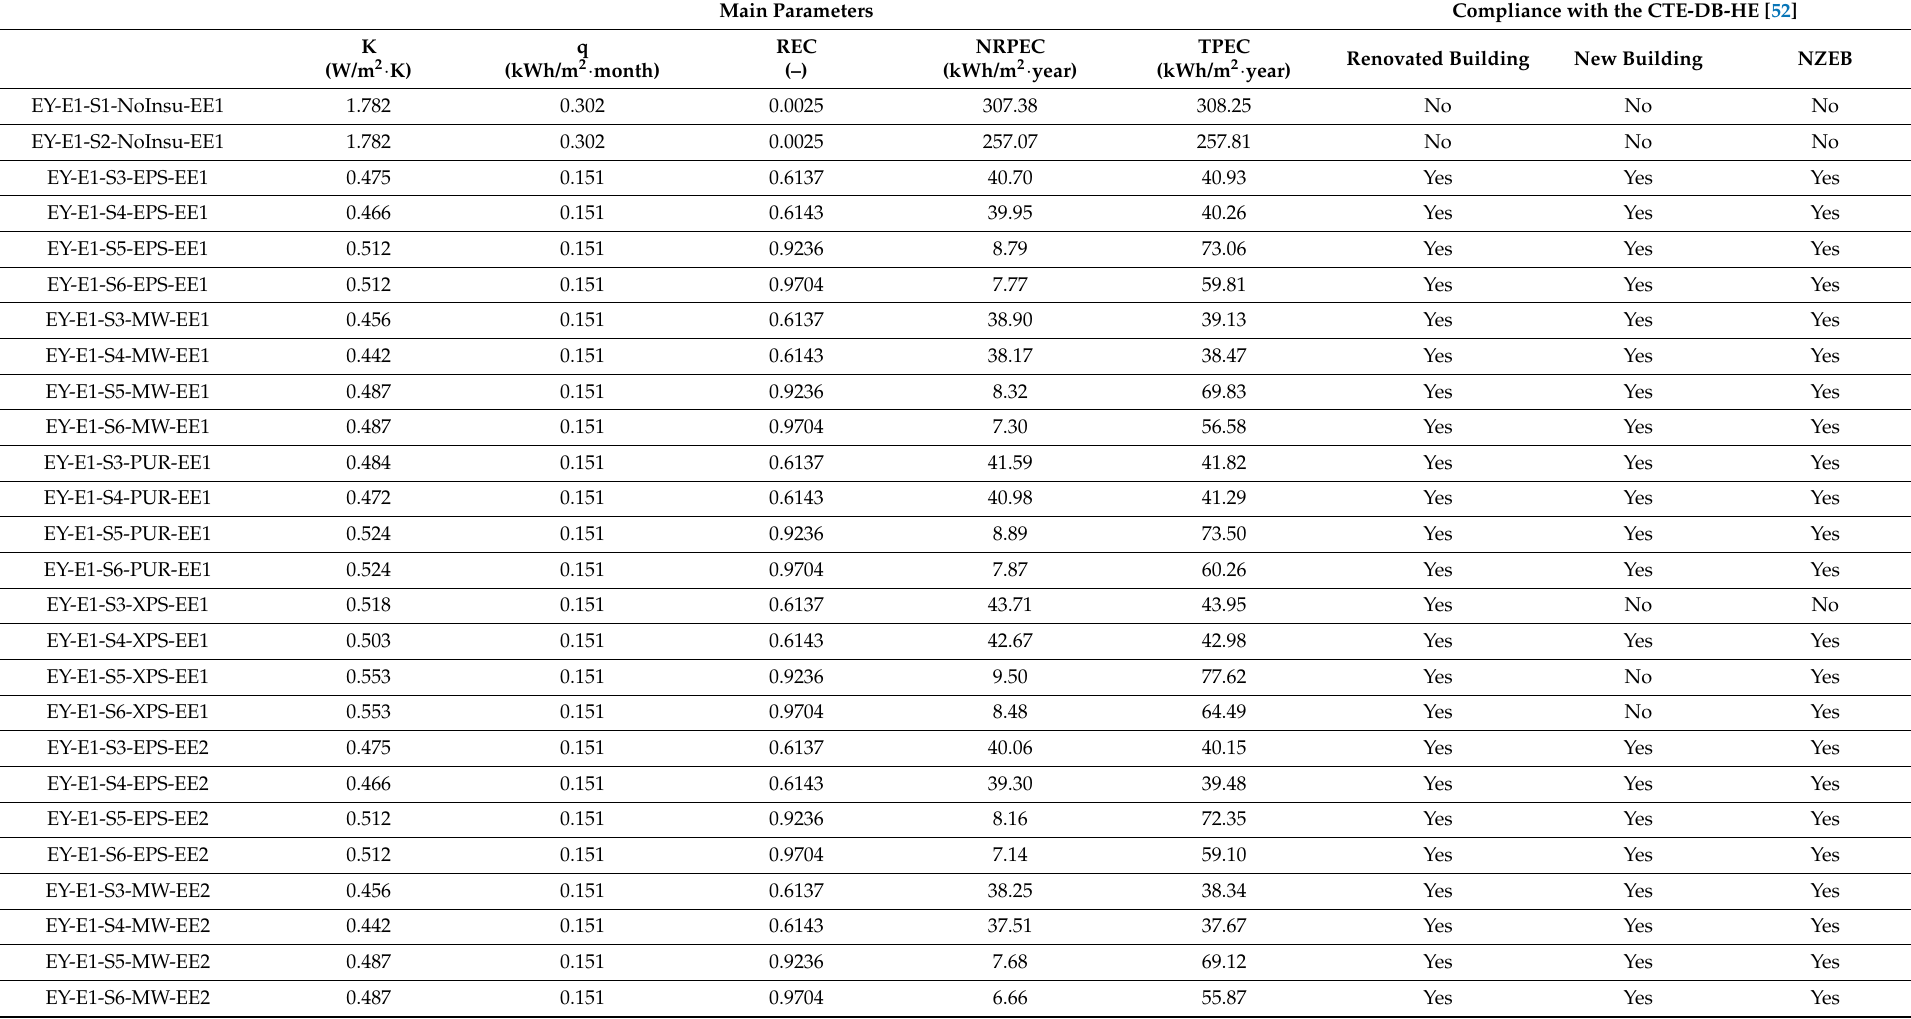
Table A4. Verification of compliance with the CTE-DB-HE [52] for each case study in Torrecilla en Cameros (CCZ EY-E1). Main